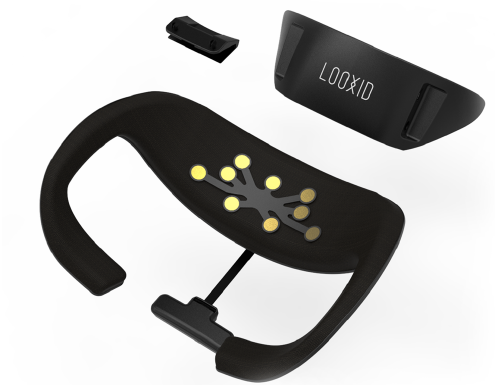
Figure 4. Looxid Link Package for VIVE Pro/VIVE Pro Eye